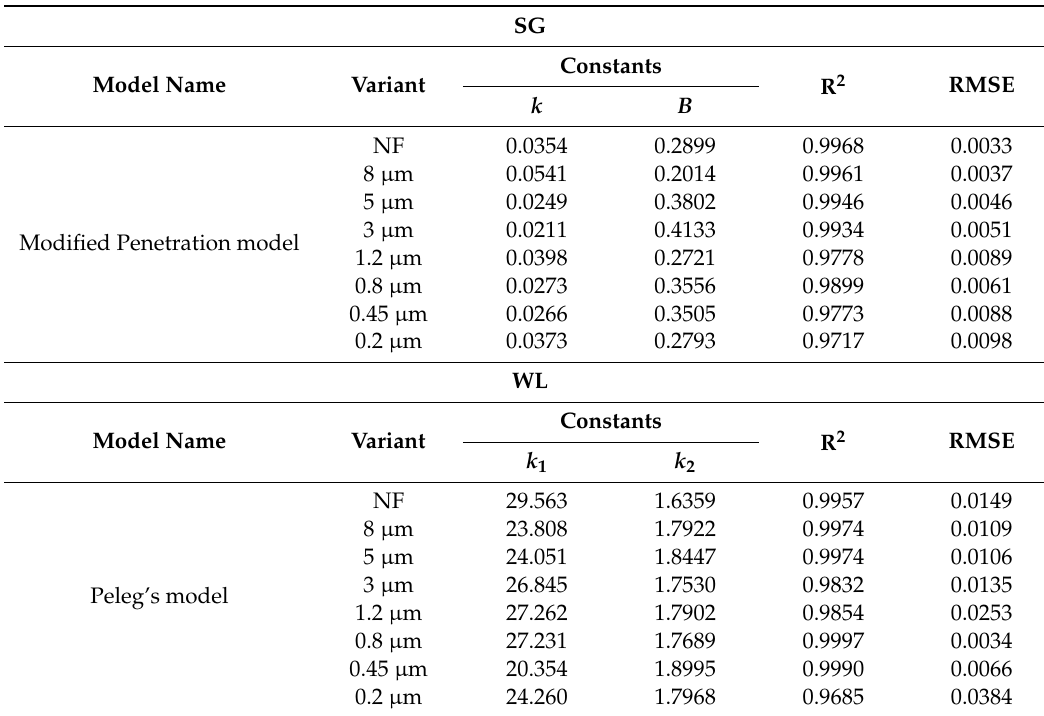
Table 2. Mathematical models with drying constants and coe ffi cient of determination, R 2 , as well as RMSE for SG and WL of osmotically dehydrated